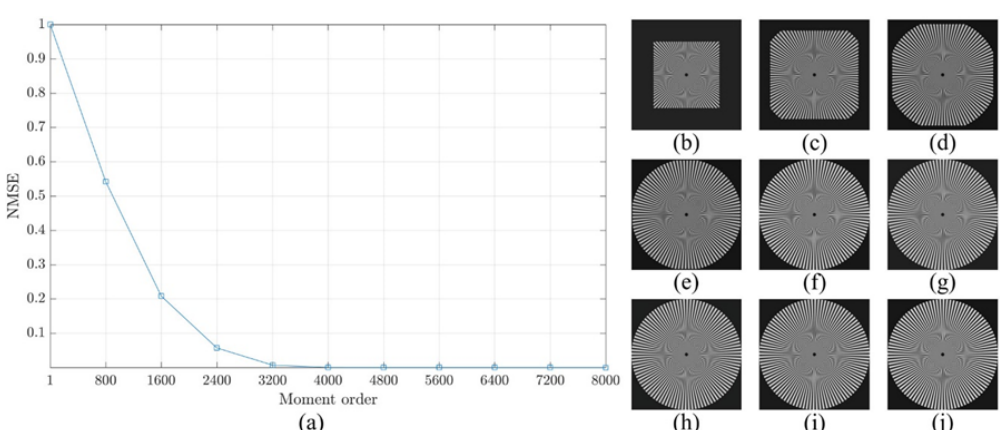
Figure 10. Construction analysis for the proposed method using sinusoidal Siemens start with ω = 100. ( a ) NMSE, image reconstructed using number of moment equal to ( b ) 800, ( c ) 1600, ( d ) 2400, ( e ) 3200, ( f ) 4000, ( g ) 4800, ( h ) 5600, ( i ) 6400, and ( j )